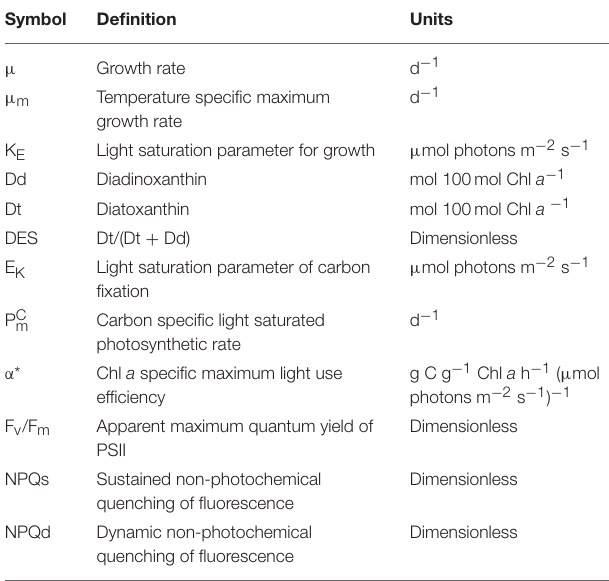
TABLE 1 | Terminology of the parameters used in this study, and their